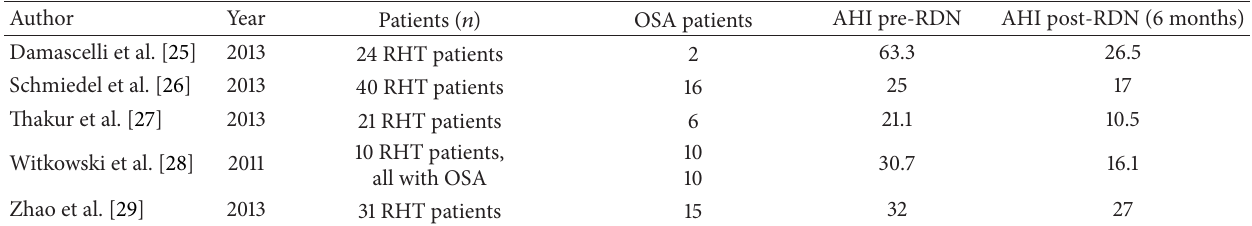
Figure 1: Relationship between OSA syndrome and arterial hypertension (HT). Table 1: Major clinical studies carried out in patients with AHS syndrome undergoing RND therapy. Modified by Shantha and Pancholy